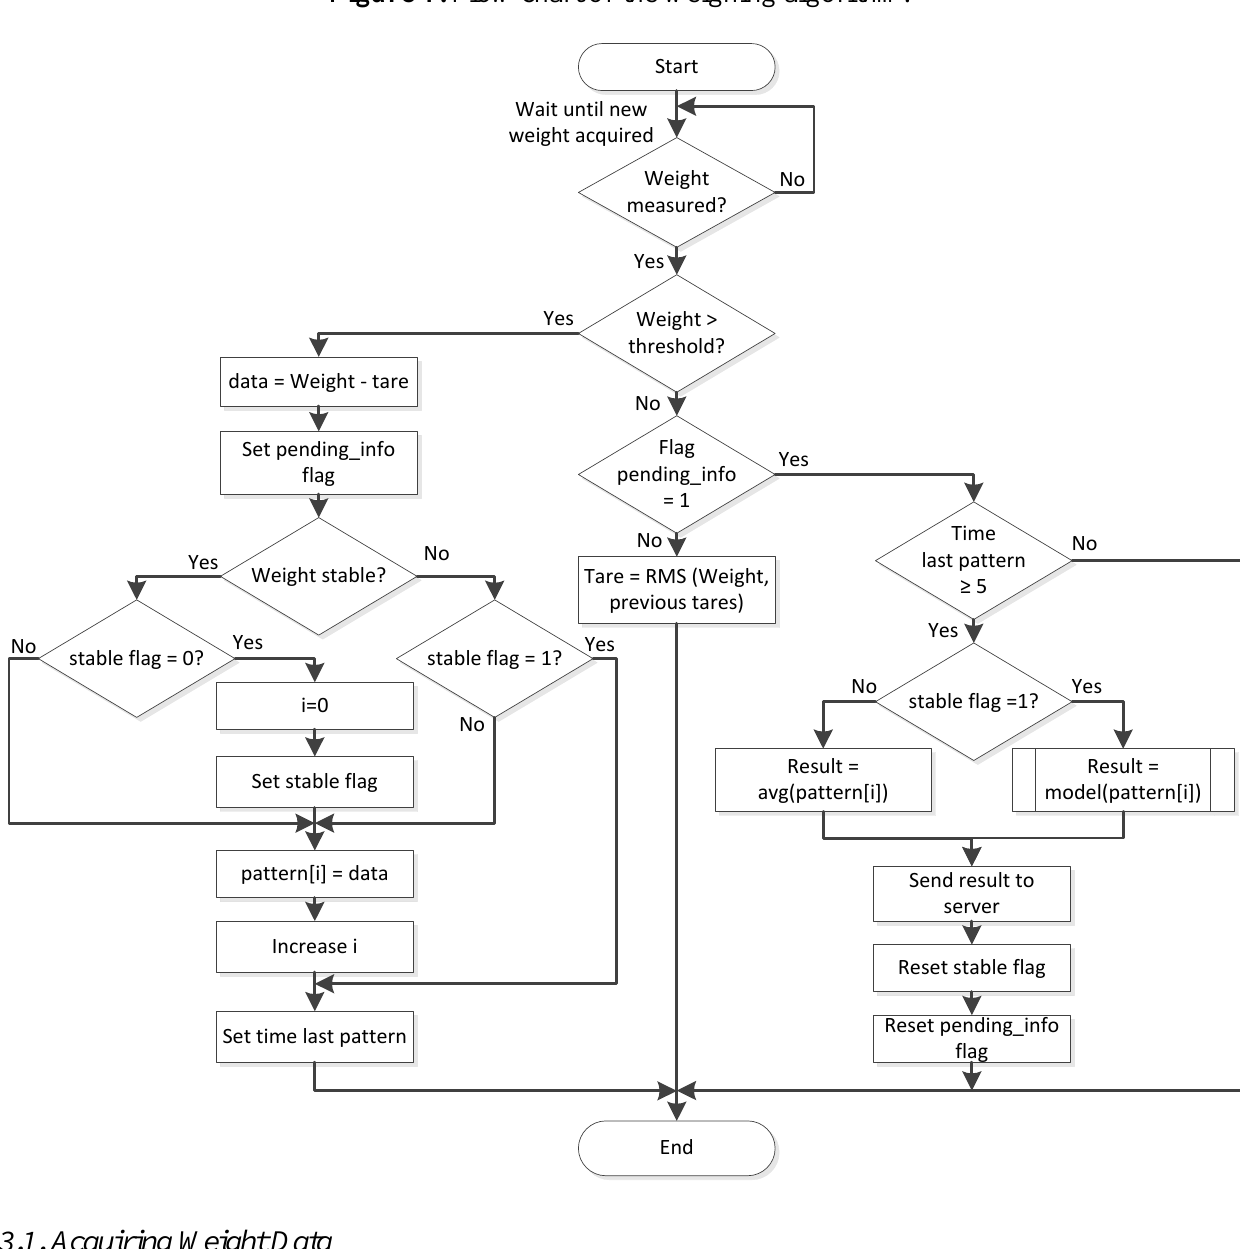
Figure 1. Flow chart of the weighing